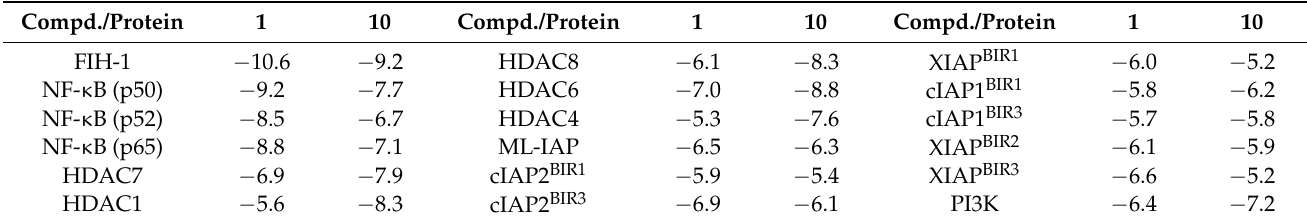
Table 2. Docking scores (minimal, kcal/mol) of 1 and 10 from their binding to FIH-1, NF- κ B, HDACs, IAPs, and PI3K.